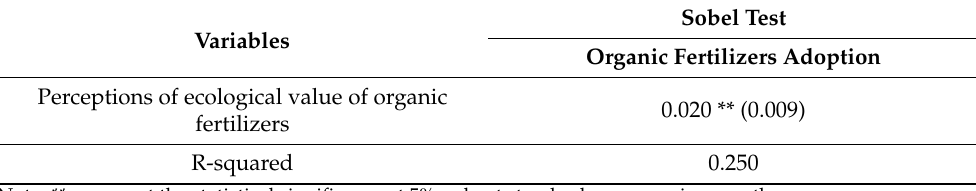
Table 8. The results of the Sobel